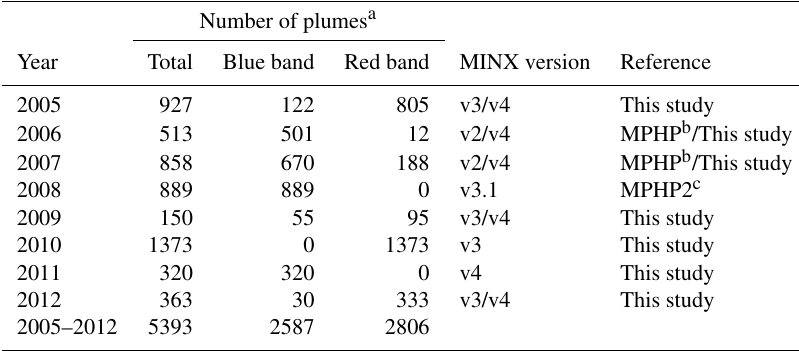
Table 1. Summary of MISR smoke plumes over the Amazon domain